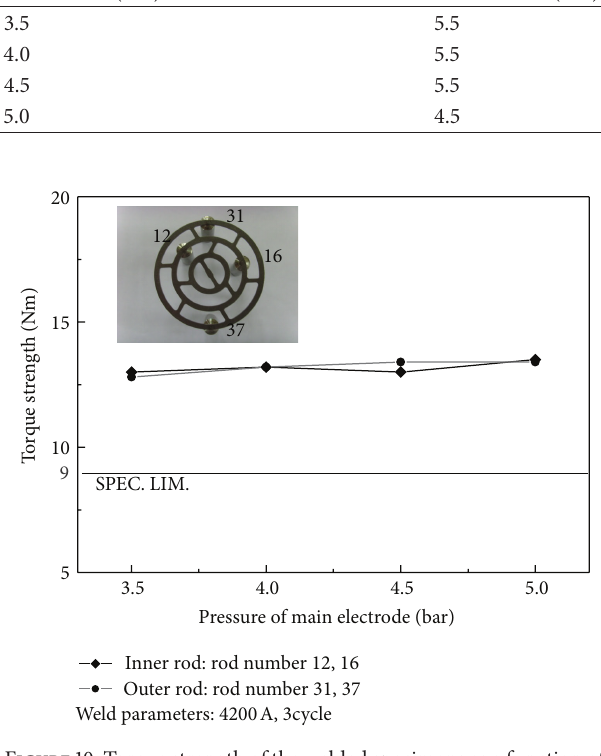
Figure 10: Torque strength of the welded specimens as a function of the pressure of main